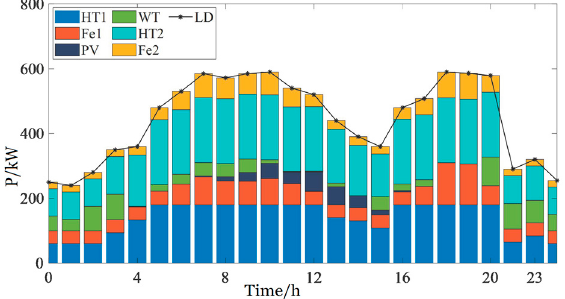
Figure 14. Total power generation and load. Table 4. Results comparison of hours in a day.